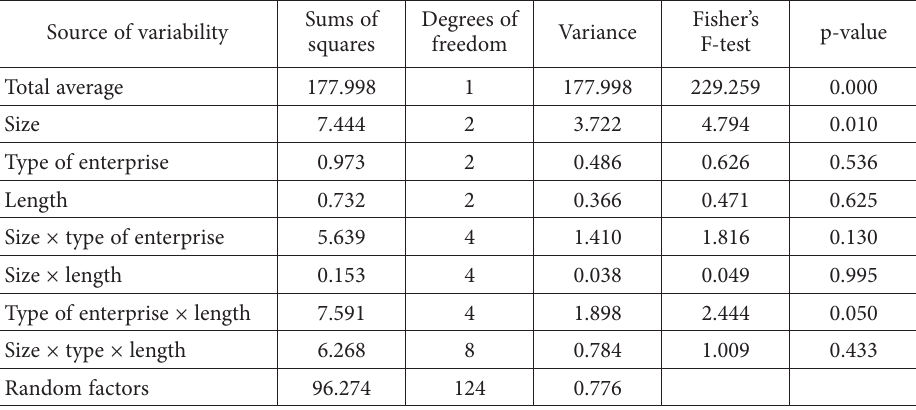
Table 5. Three-factor analysis of variance